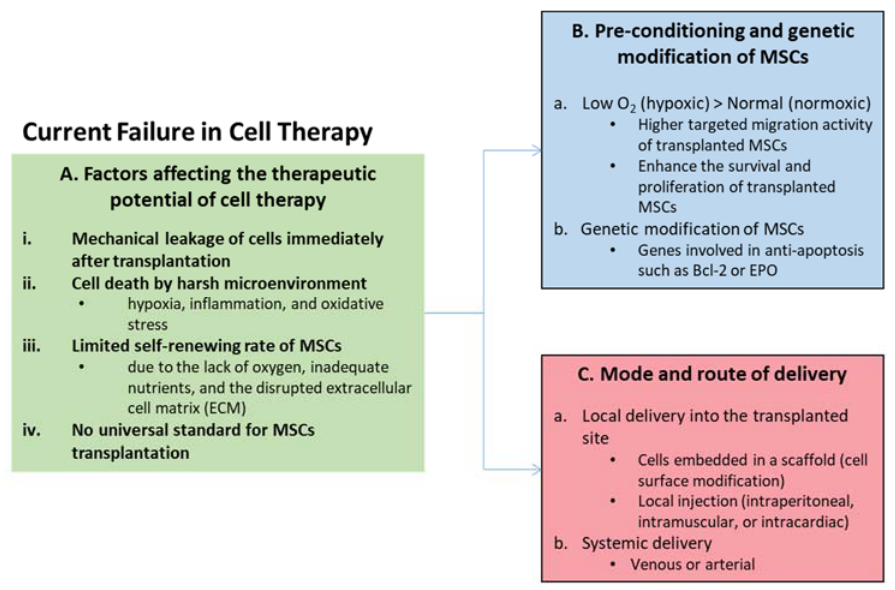
Figure 1. Current failures in cell therapy. ( A ) The patient’s age and mechanical and pathological conditions are among the factors that a ff ect the therapeutic potential of cell therapy. In particular, transplanted cell survival may be a ff ected by (i) mechanical stress during the transplantation procedure; (ii) a harsh microenvironment due to the activation of inflammation-related factors; (iii) oxygen and nutrient starvation due to poorly vascularized environments at the site of implantation; and (iv) a lack of optimization of the delivery protocols. ( B ) The benefits of cell transplantation could be improved by donor cell preconditioning or modifying transplanted cells prior to implantation to support or enhance their resistance to hypoxic stress. ( C ) The tissue engineering approach could enhance the survival of transplanted cells through the use of suitable biomaterials as carriers, such as a biologic-derived ECM sca ff old. O 2 = oxygen; Bcl-2 = B-cell lymphoma 2; EPO = erythropoietin.